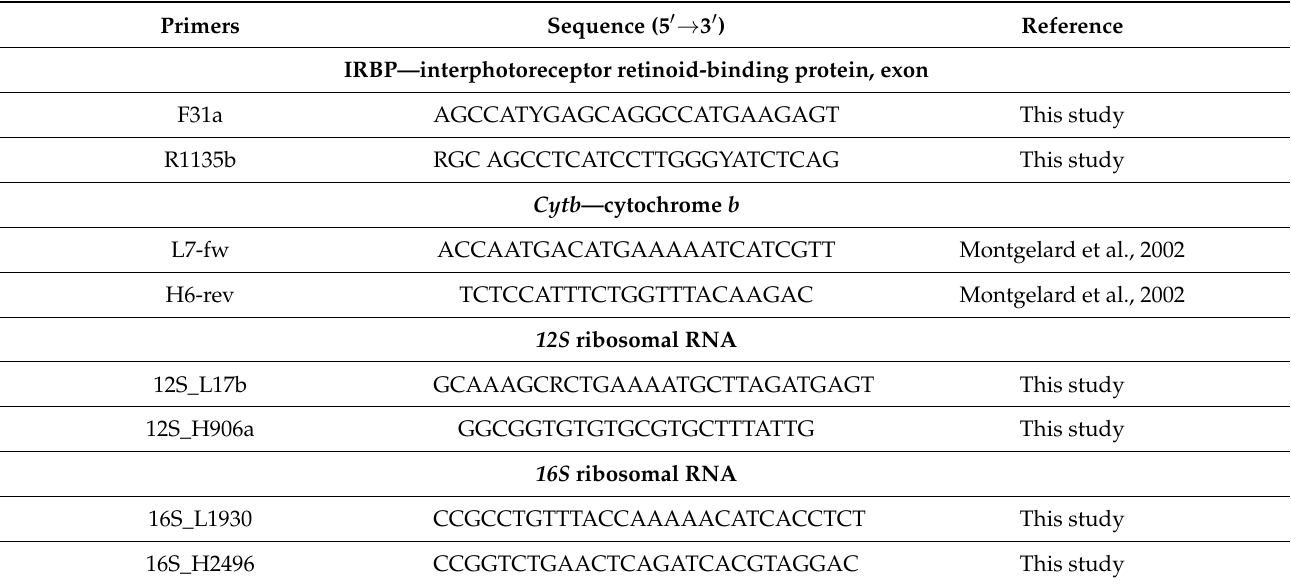
Table 1. The primers used for amplification and sequencing of the analyzed markers. Primers Sequence (5 (cid:48) → 3 (cid:48)